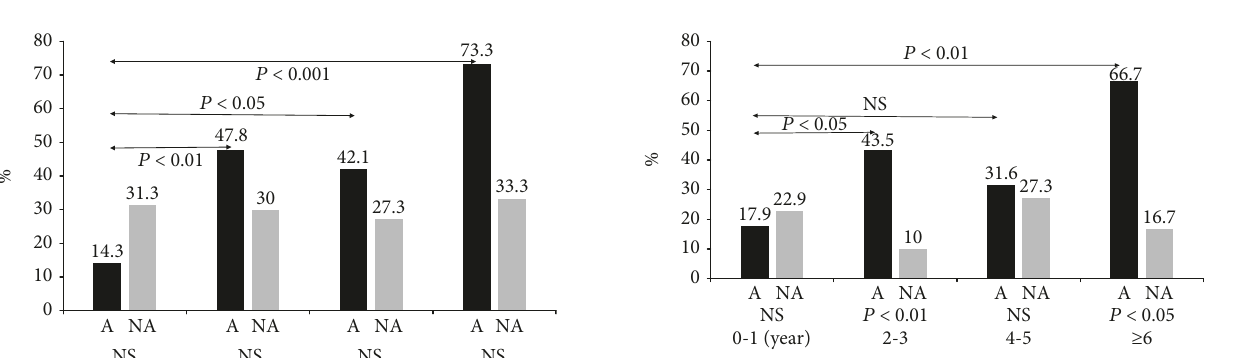
Figure 1: Nasal discharge eosinophils by age. A, asthma group; NA, nonasthma group. The positive nasal discharge eosinophil rates in the A group were signi fi cantly higher in patients aged 2-3 years, 4-5 years, and > 6 years than in patients aged 0-1 years ( p < 0 05 − 0 001 , chi-square test).